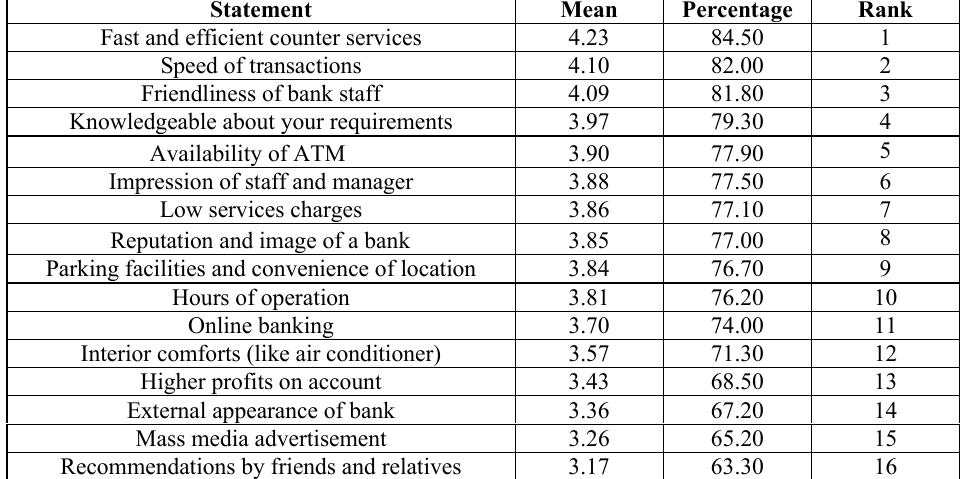
Table 2: Young Customer’s Priorities towards General